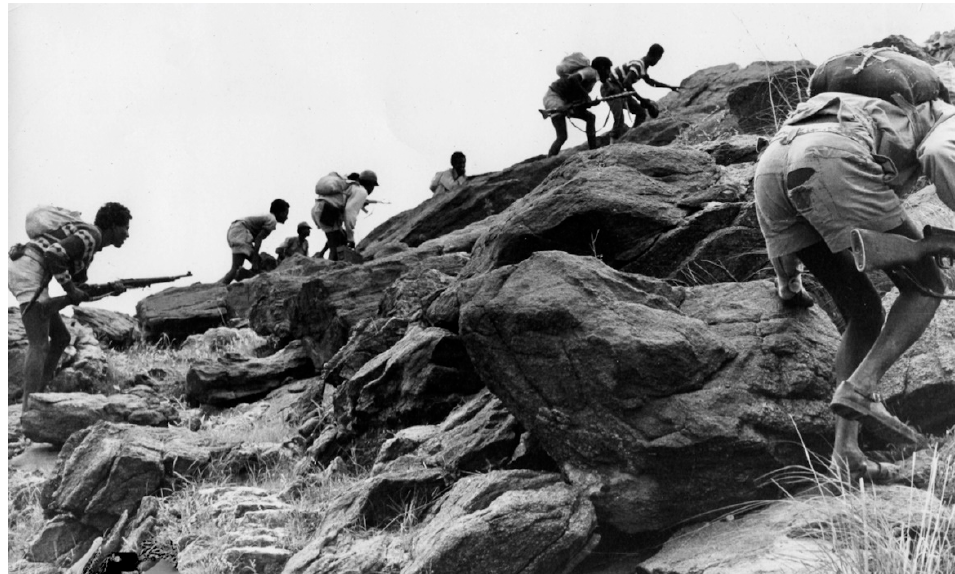
Figure 6. Eritrean People’s Liberation Front (EPLF) soldiers during the war for independence from Ethiopia; photo credit Gwynne Roberts (copyright Gwynne